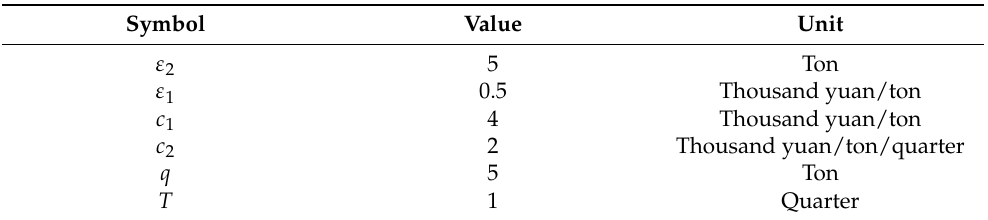
Figure 5. Joint effect of price and demand forecasts on optimal sales incentives, production quantity, and expected profits. Table 6. The parametric values of the sequential optimization decision model when the prediction values of refined oil price and demand are